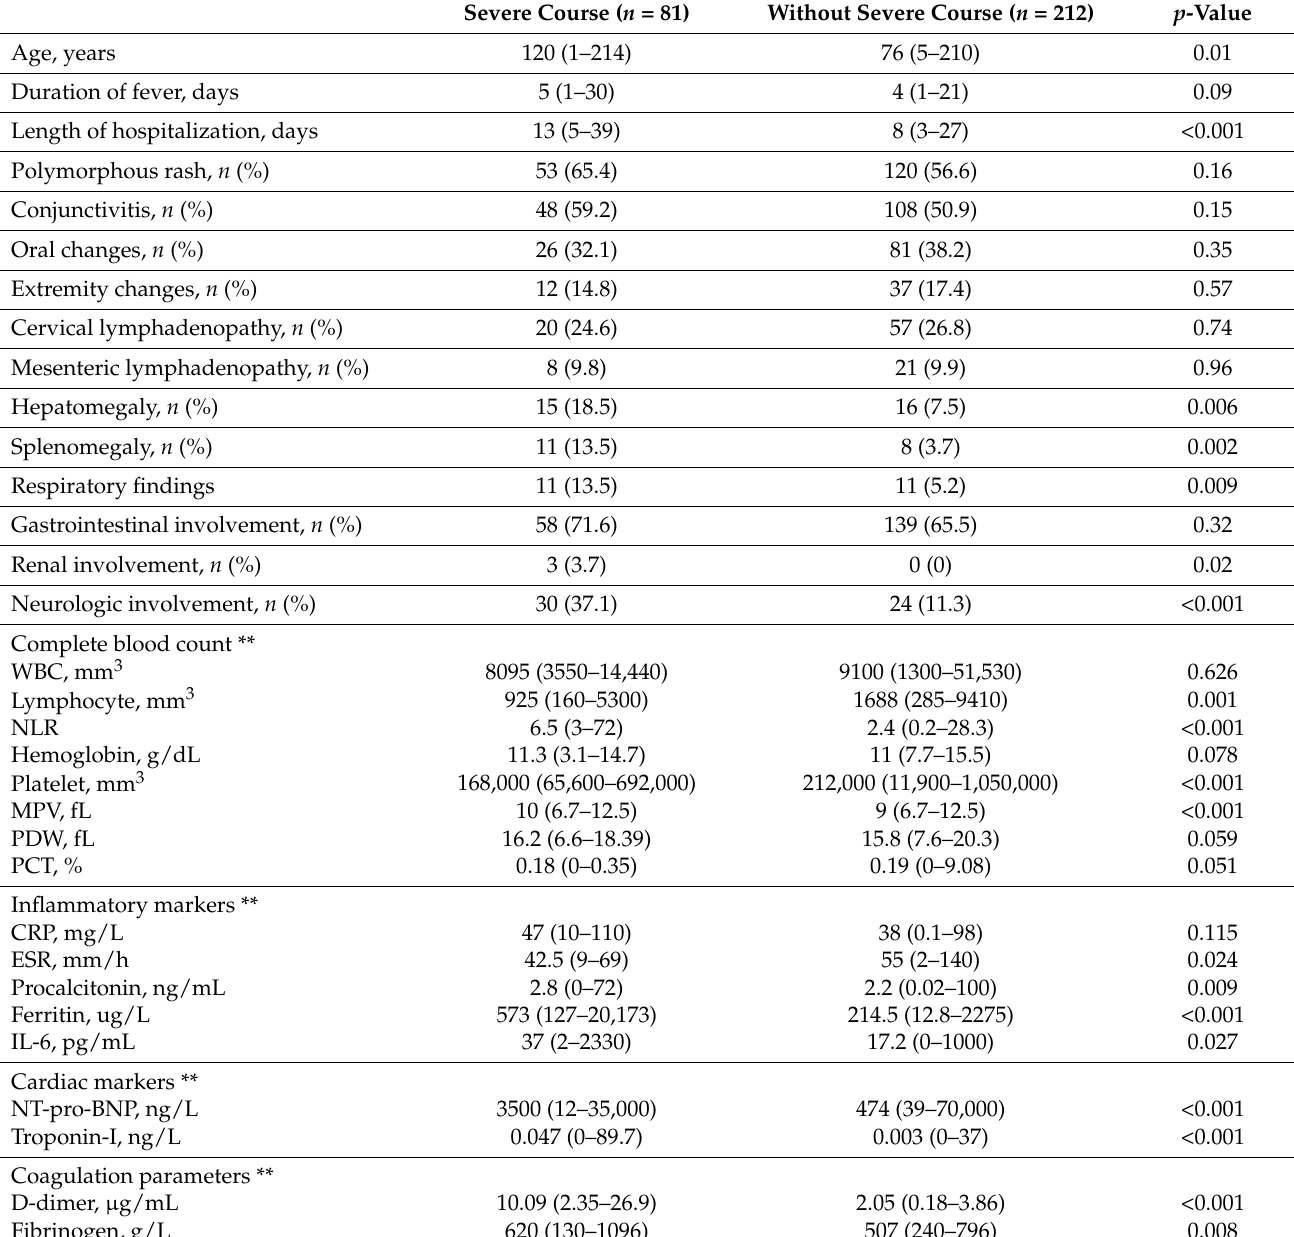
Table 4. Comparison of patients with the severe course and without severe